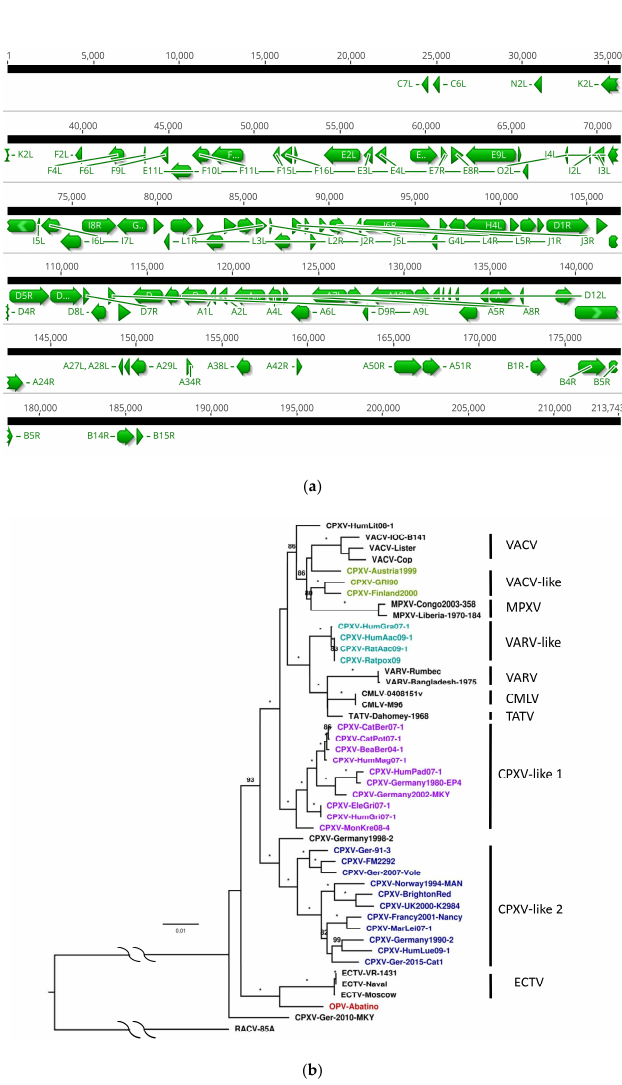
Figure 1. Location and phylogenetic analysis of the core genome of Orthopoxvirus (OPV) Abatino: ( a ) Localization of individual 102 coding sequences (CDS), highly conserved across all analyzed OPV, within the OPV Abatino genome. CDS are annotated following vaccinia virus-Copenhagen (VACV-Cop) nomenclature; ( b ) phylogenetic analysis of the core genome of OPV Abatino, built with the 102 concatenated CDS in the context of representative OPV genomes. CPXV clades, defined according to [2,5,17–19], are identified with color codes; three cowpox virus (CPXV) strains with discordant or no specified classification are also reported in black characters. The OPV Abatino strain is highlighted in red. A New World OPV, i.e. Raccoonpox Virus (RACV), was used as an outgroup. The CDS used in this analysis are detailed in Supplementary Table